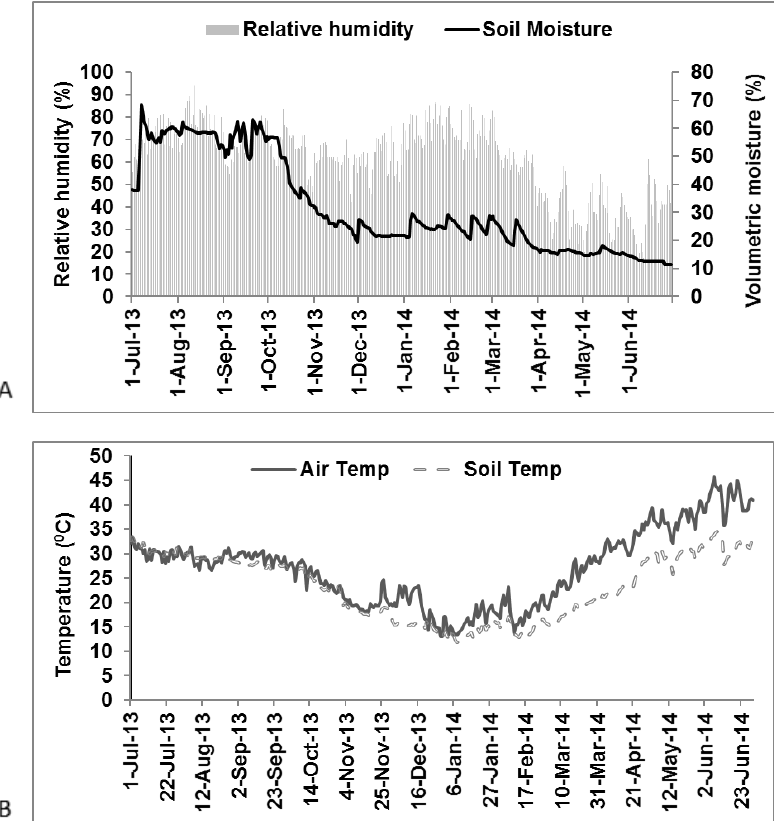
Figure 1. Variations in ( A ) relative humidity and soil moisture ( B ) air temperature and soil moisture during the study period.